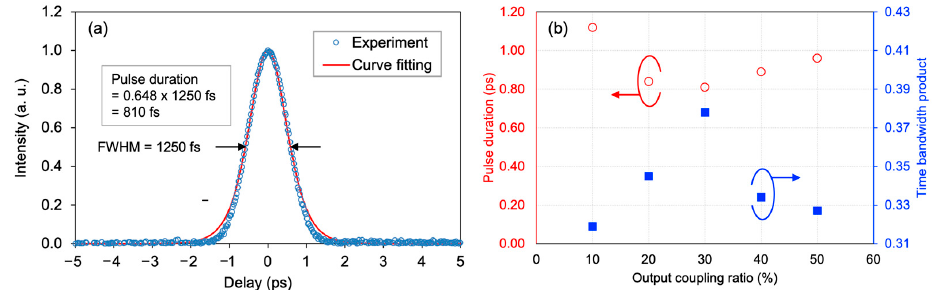
Figure 11. Pulse duration of EDFL with GNP-SA; ( a ) autocorrelator trace of the output pulse using a 30% output coupling ratio and ( b ) the pulse duration value of different output coupling ratio values.